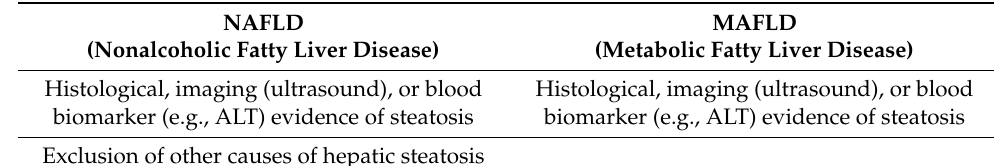
MAFLD (Metabolic Fatty Liver